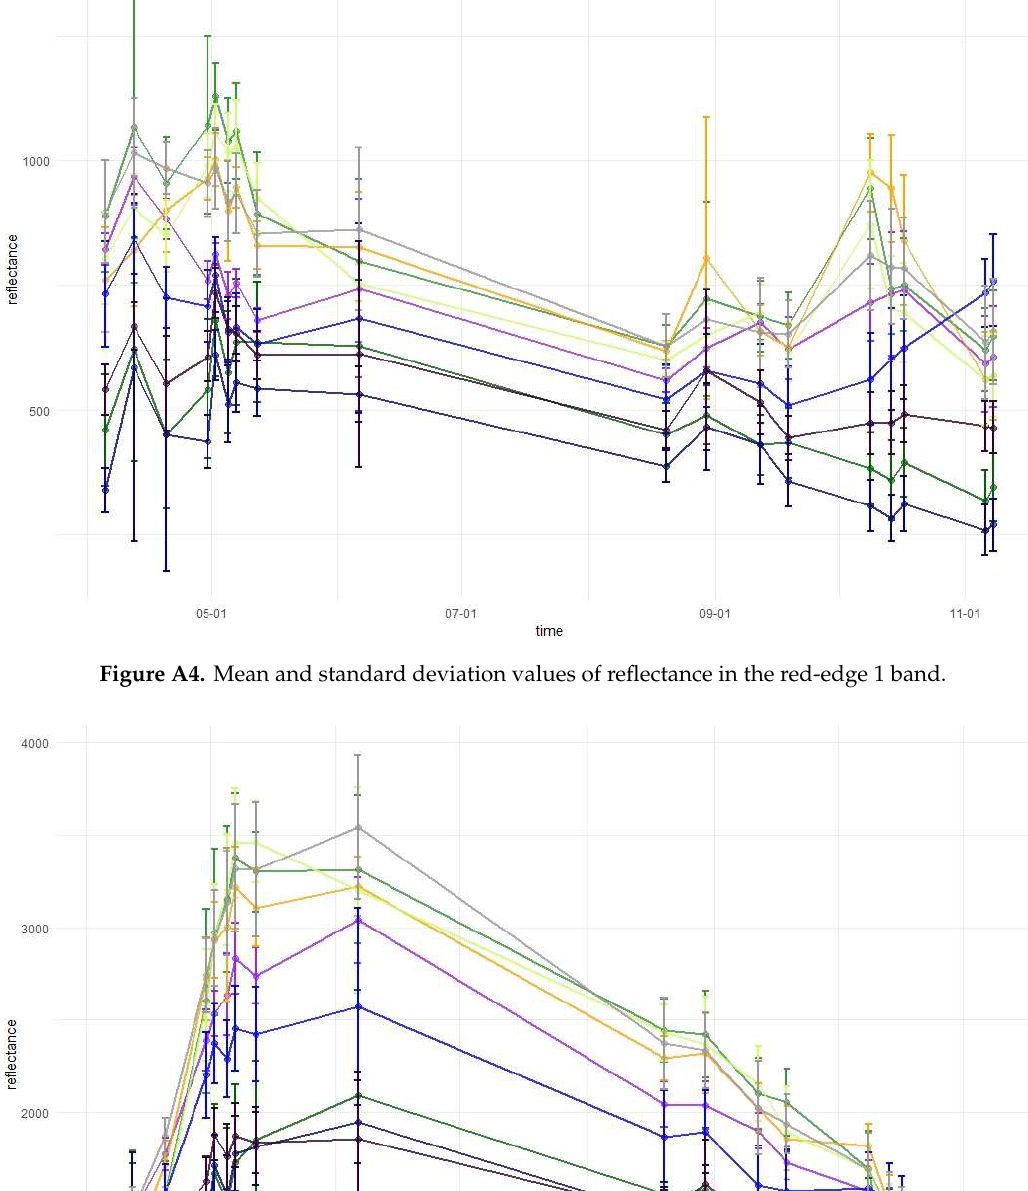
Figure A3. Mean and standard deviation values of reflectance in the visible red band.